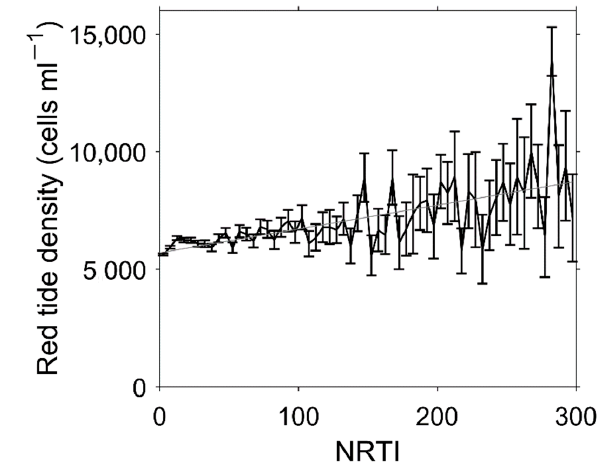
Figure 12. Variations of in situ red tide density (cells mL − 1 ) as a function of NRTI at the matchup locations between satellite data and in situ measurements of red tide from 2012 to 2015, where the dashed line represents the least-squared linear fit between the NRTI and the red tide density, and the bars of each bin represent the mean errors expressed as the upper and lower limits of the 1 standard error of the in situ red tide density.